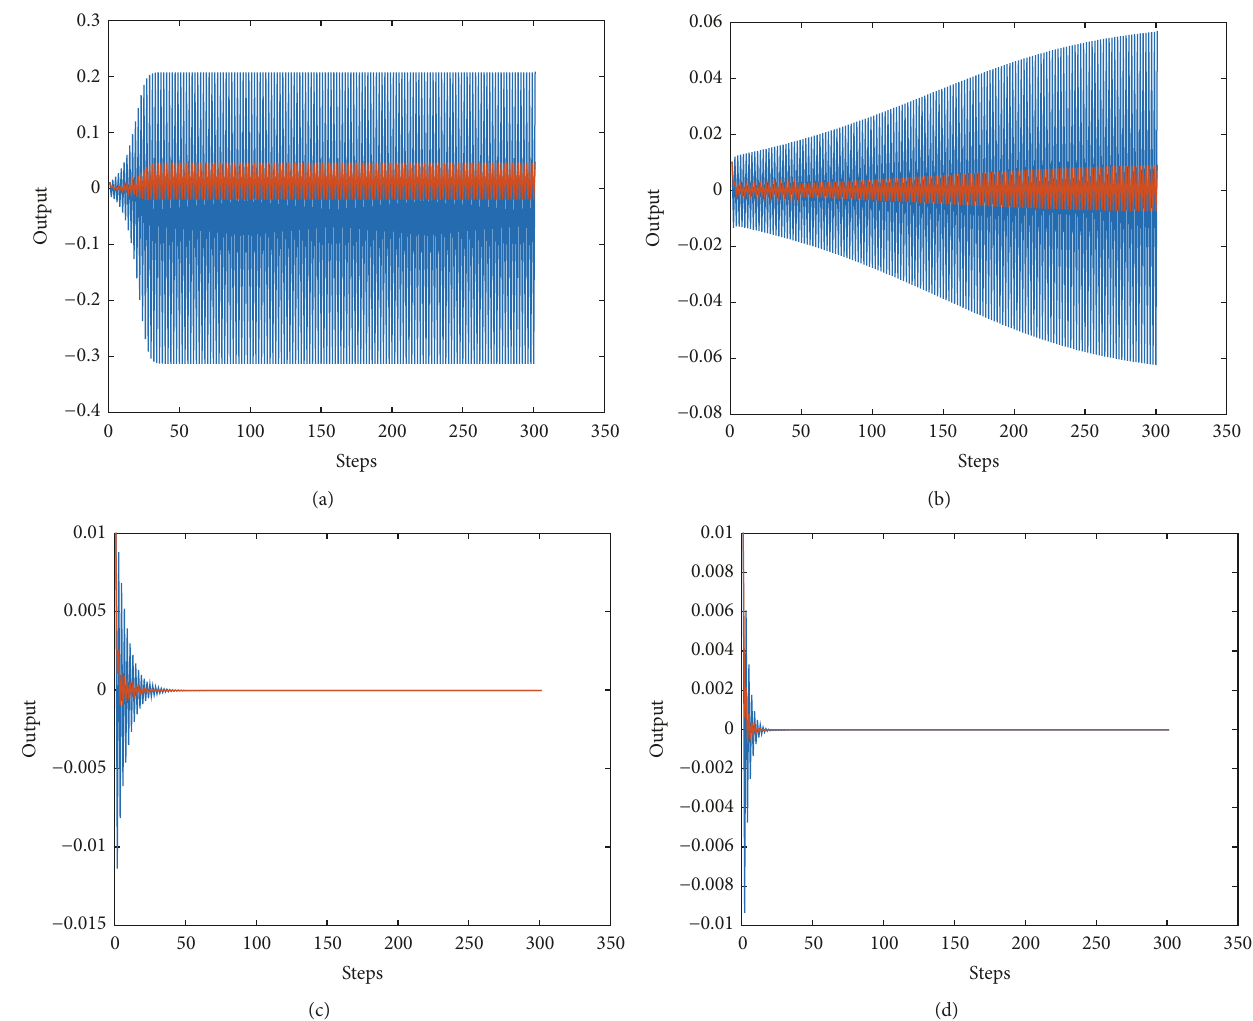
Figure 3: The changing of the output of the controlled system (a) 𝜀 = 0.8 ; (b) 𝜀 = 1 ; (c) 𝜀 = 1.2 ; (d) 𝜀 = 1.4 .